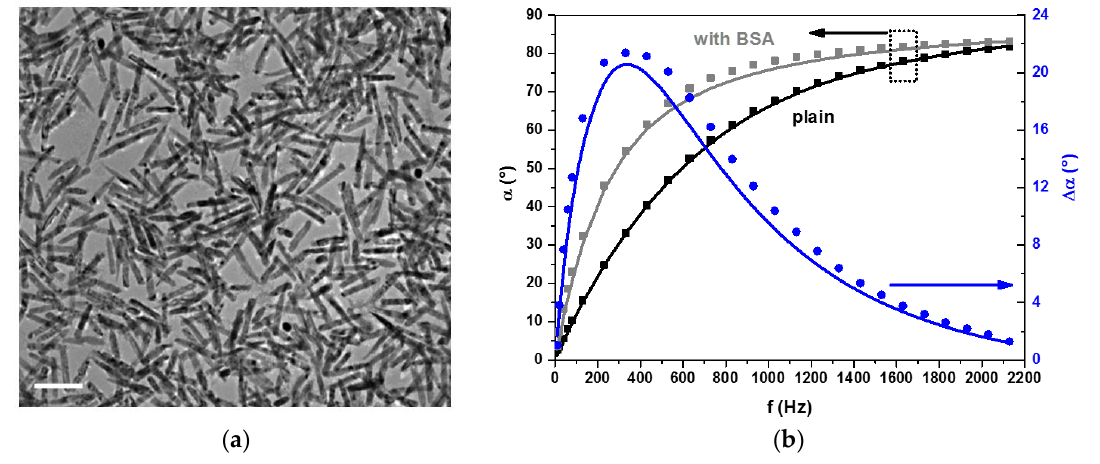
Figure 19. Ni nanorods and protein adhesion results: ( a ) TEM image of Ni nanorods. The scale bar corresponds to 200 nm. The mean nanorod length is 182 ± 29 nm and the mean diameter 26 ± 3 nm. Reprinted with permission from Reference [290]. Copyright 2014, John Wiley and Sons; ( b ) Phase lag α spectra in dependence of the external magnetic field frequency f of Ni nanorods under addition of BSA protein and of plain nanorods at an applied RMF strength of 1 mT (left axis) and corresponding relative phase difference Δα (right axis). Measured values (dots) are compared to the calculated model fits (lines). The relative phase difference Δα (blue) reaches a maximum value of about 22° at a frequency f of 330 Hz. Modified graph reprinted with permission from [290]. Copyright 2014, John Wiley and Sons.